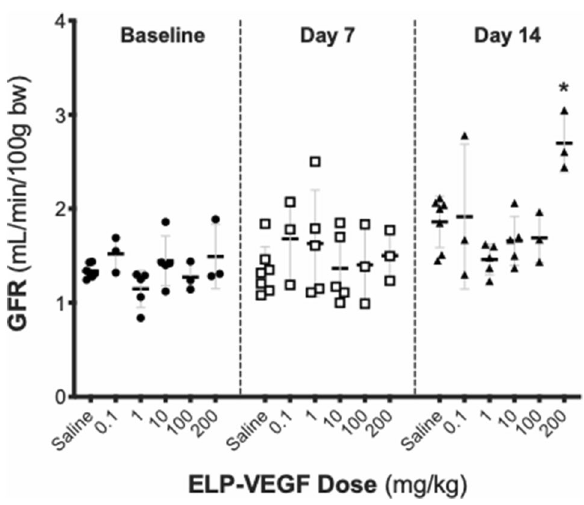
Figure 3. Effect of ELP-VEGF on Renal Function. Glomerular filtration rate (GFR) was assessed by transcutaneous measurement of FITC-sinistrin clearance prior to treatment and 7 and 14 days after treatment with ELP-VEGF at increasing doses. * Statistically significant increase relative to saline treated rats, p < 0.05, two- way ANOVA with post-hoc Dunnett correction for multiple